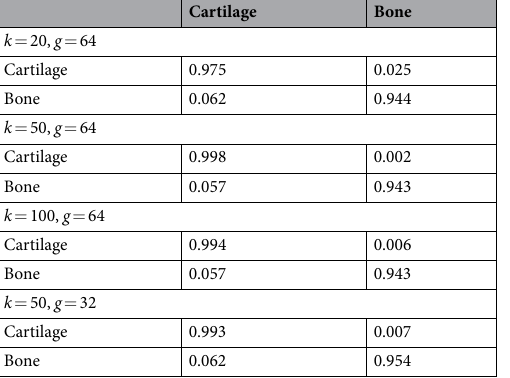
Table 1. Results of BoF classification tests performed on SHG images of tissue sections. The probability of the confusion matrix is shown. Texture BoF method for k = 20, 50, or 100 and g = 32, 64 are